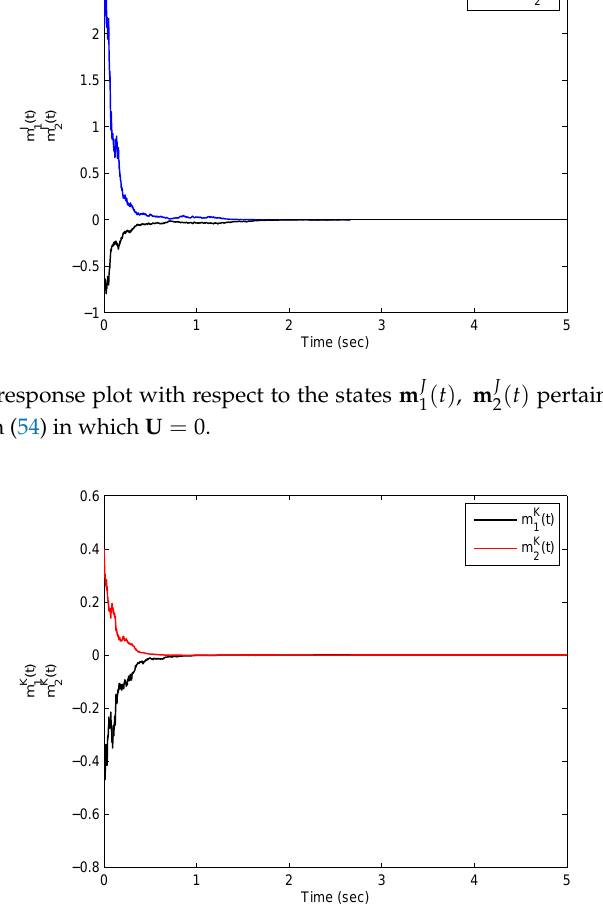
Figure 8. A time response plot with respect to the states m K model in Equation (54) in which U =